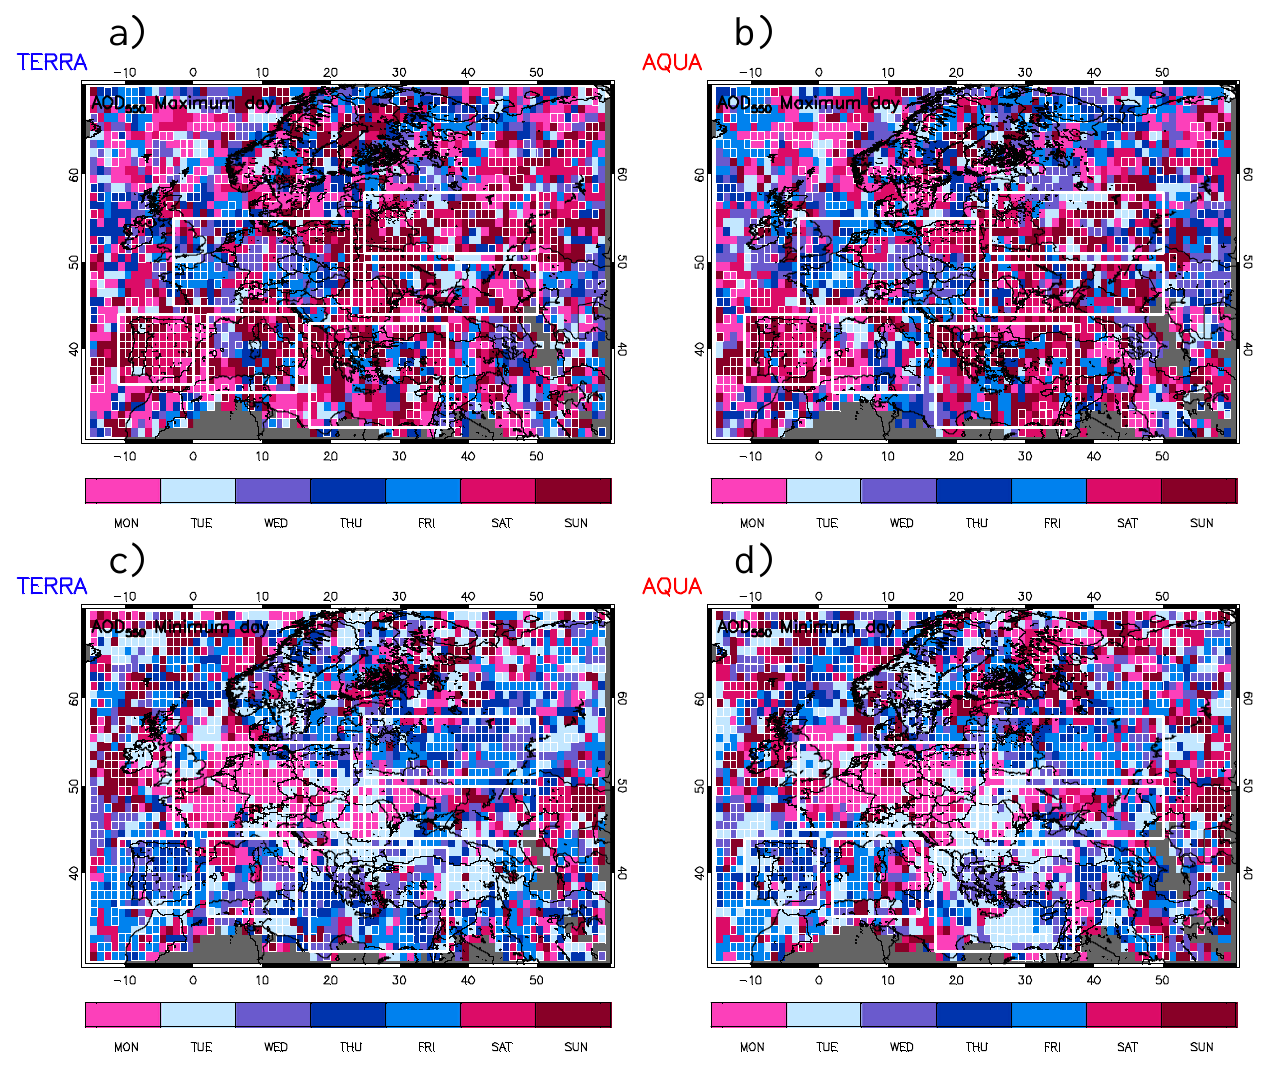
Fig. 3. (a, b) Day of maximum APD calculated from TERRA and AQUA MODIS AOD 550 measurements, (c, d) Day of minimum APD cal- culated from TERRA and AQUA MODIS AOD 550 measurements. The grid cells with a statistically significant value at the 90% confidence level according to the two tailed t-test appear with a thin white outline. The six regions of interest are marked with a thick white outline in all the